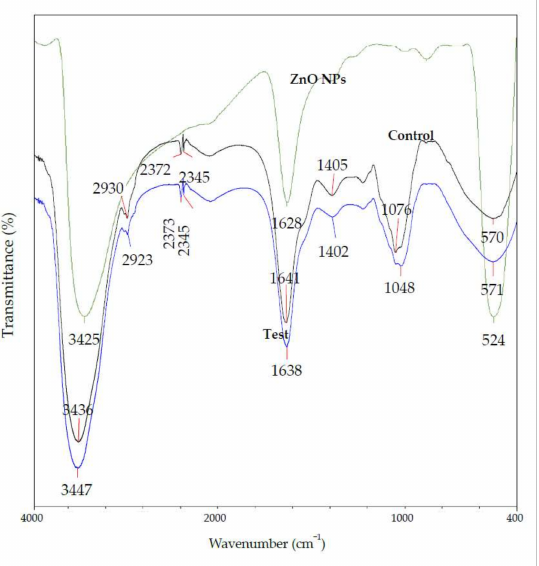
Figure 6. FTIR spectra of ZnO NPs, C. albicans negative control, and C. albicans treated with 160 µ g/mL ZnO NPs